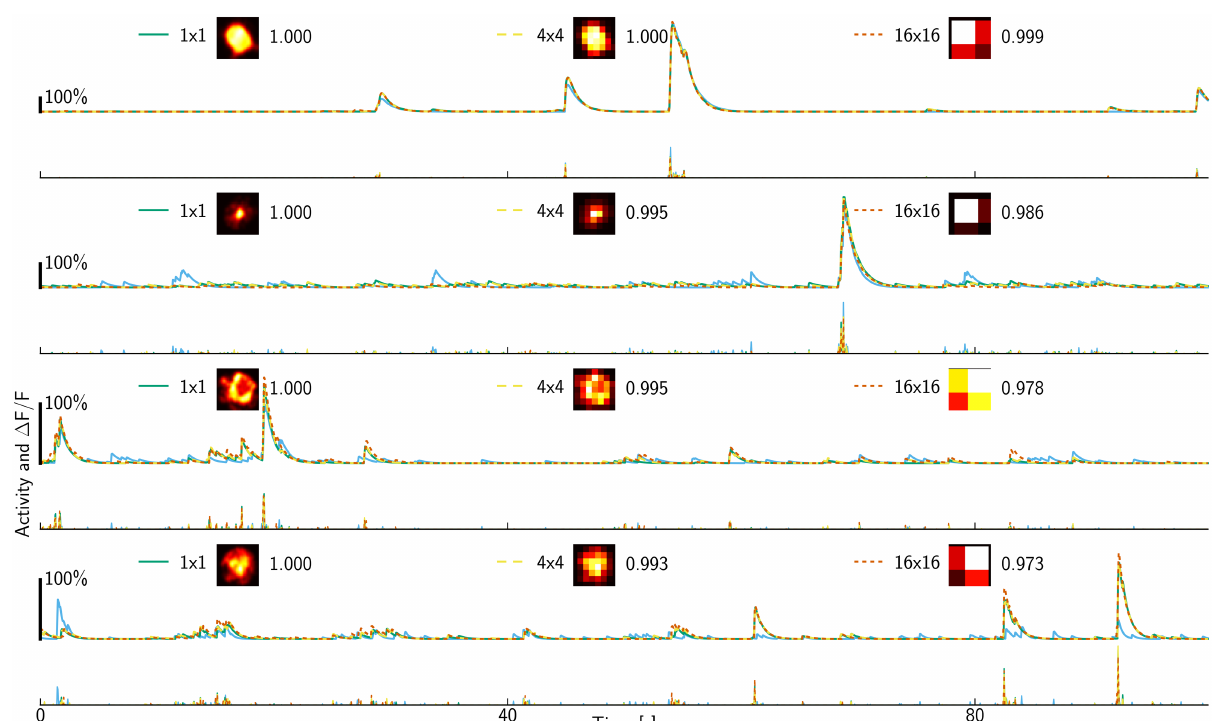
Fig 5. Inferred denoised and deconvolved tracesfor ROIs with rank 1, 40, 80 and 120 (top to bottom) out of a total of N = 187 ROIs in the 2P dataset. In each row, a denoised trace from C l is shown abovethe corresponding deconvolvedtrace from S l . Shapeswere decimatedby averaging 4 × 4 or 16 × 16pixels. The legendshows the resultingshapes A l as well as the correlationof the inferred denoised fluorescence C l versus the estimate C 1 obtained without decimation. Further, the results obtainedwith merely 1-phaseimagingfor decimationby 4 × 4 pixels are shown as cyan traces.